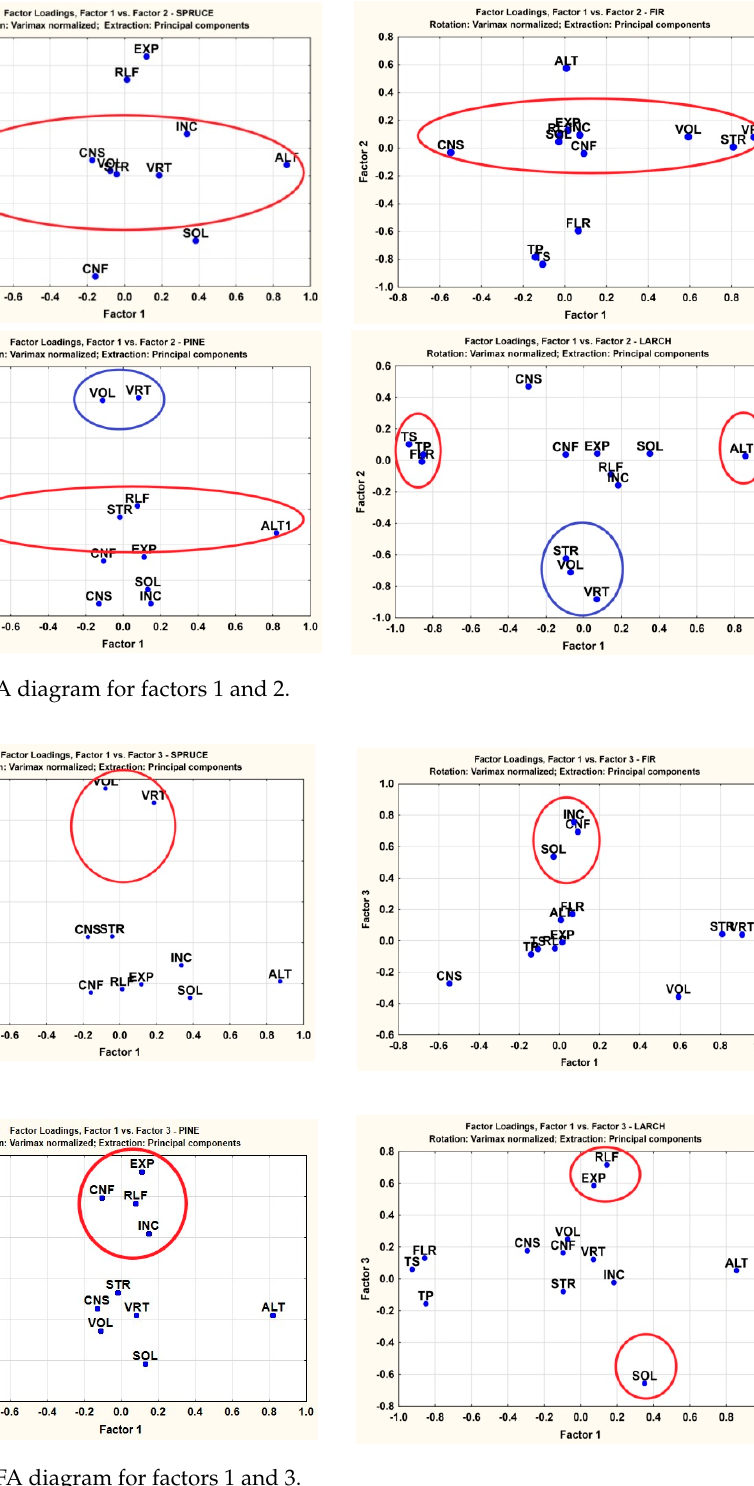
Figure 10. FA diagram for factors 1 and 3.